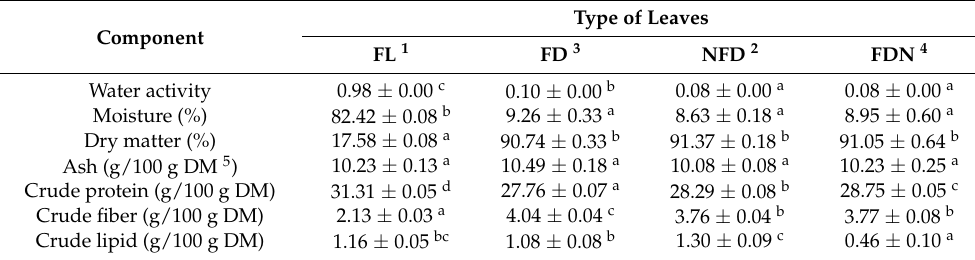
Table 1. Proximate composition and water activity of SBLs with different